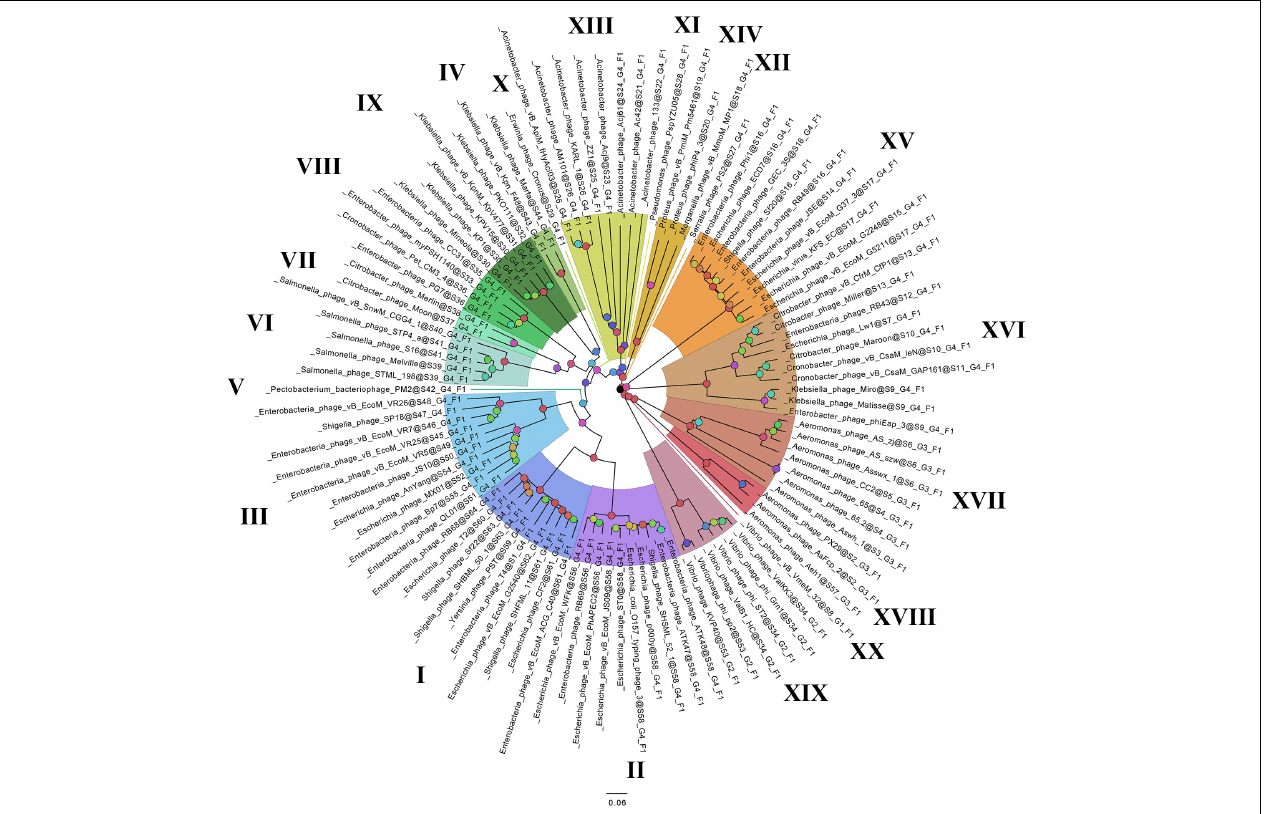
FIGURE 3 | The phylogenomic tree of Tevenvirinae . Selective clades are marked with Roman numerals and colors. The statistical values presented along with the tree in Supplementary Figure 4 are marked with colored